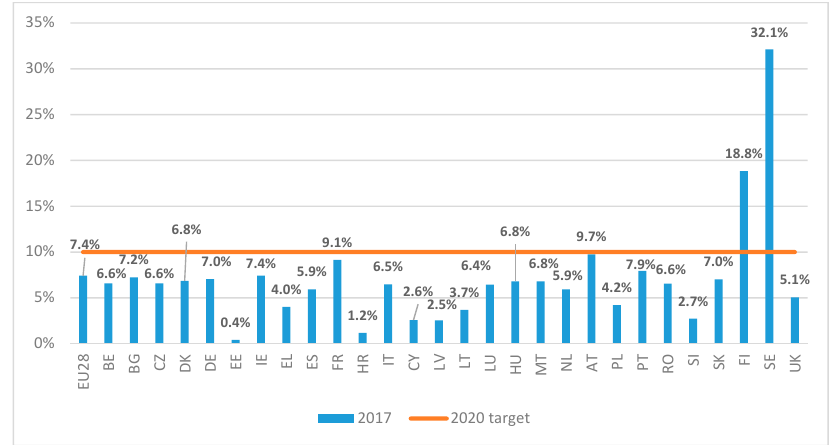
Figure 3. Share of renewable energy in transport, at the EU level, in 2017 and 2020 target. Source: own computations performed on data retrieved from Eurostat [18].